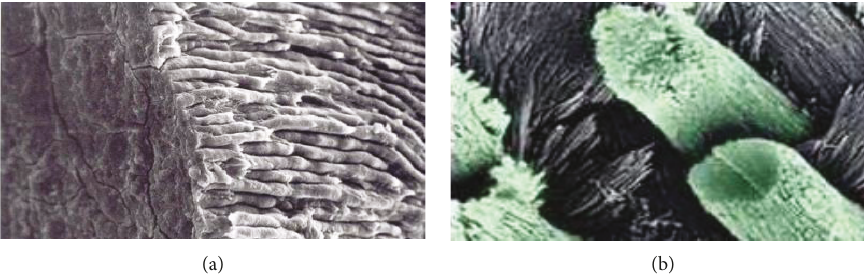
Figure 2: Micrographs of dental enamel. (a) Distribution of enamel prisms and (b) hydroxyapatite